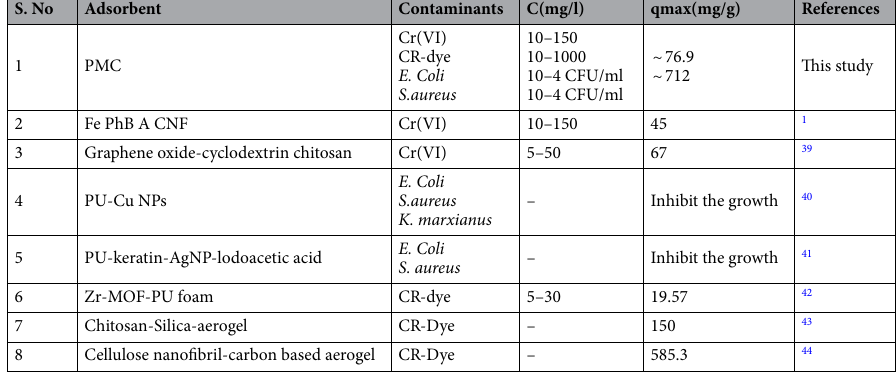
Table 4. Comparison of different hybrid materials used for the removal of